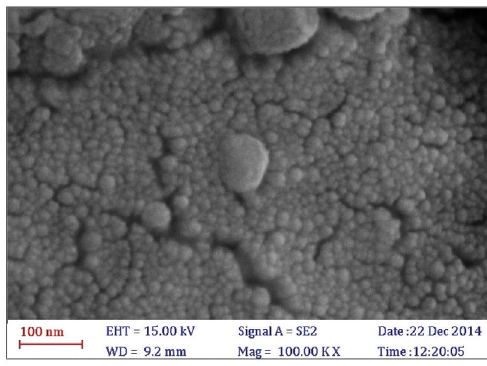
Fig. 4. The SEM image of CdO nanoparticles. Fig. 5. EDAX analysis data of CdO